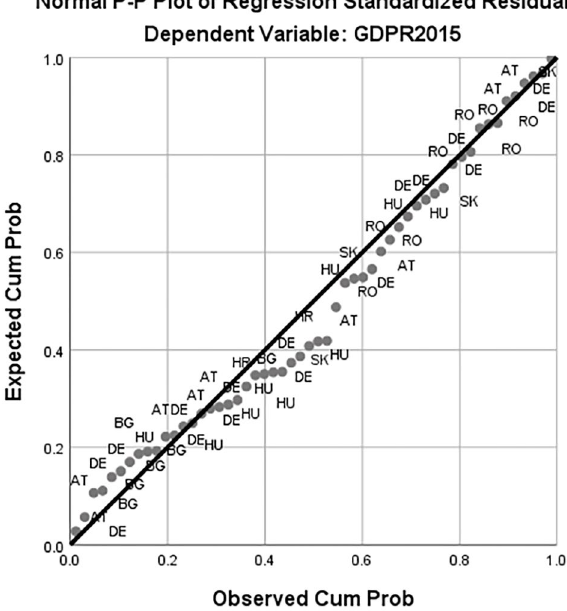
Figure 4. P-P Plot for sustainable development of EUSDR in